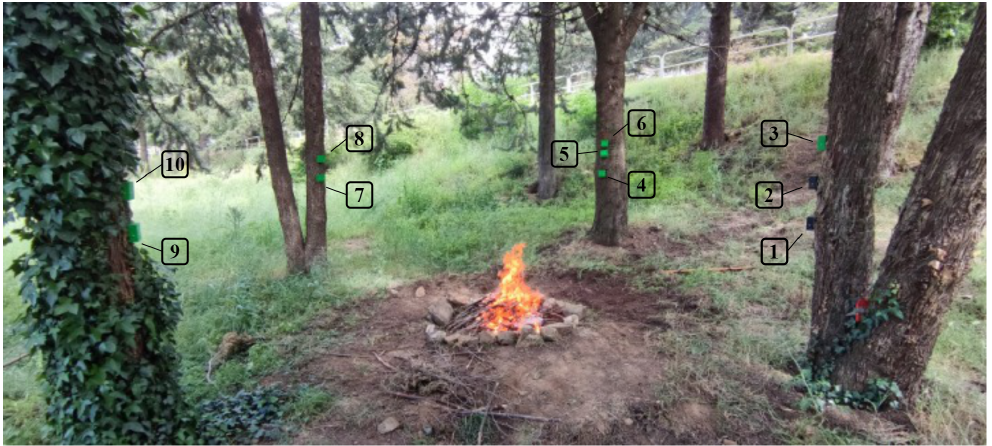
Figure 11. Scenario created to elaborate the WSE using ten nodes to form a SAFe’s WSN. Test carried out to identify the behavior of the WSN’s data acquisition during real-fire situations. All safety measures were followed, and a firefighter supervised all WSEs. Table 1. Distances from the ground and from the fire of each of the sensor modules. Module Ground [m] Bonfire [m] Node 1 1.12